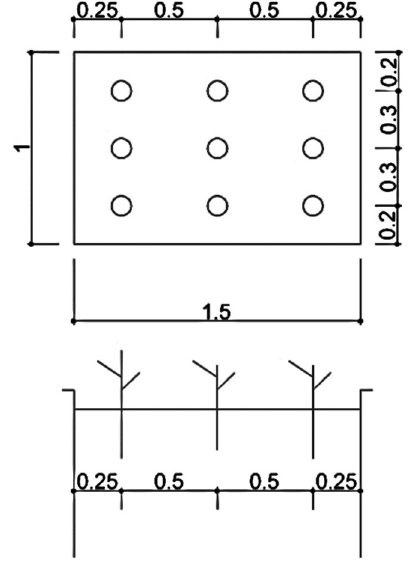
Figure 3. Schematic of the distance between potato plants in lysimeters (m).